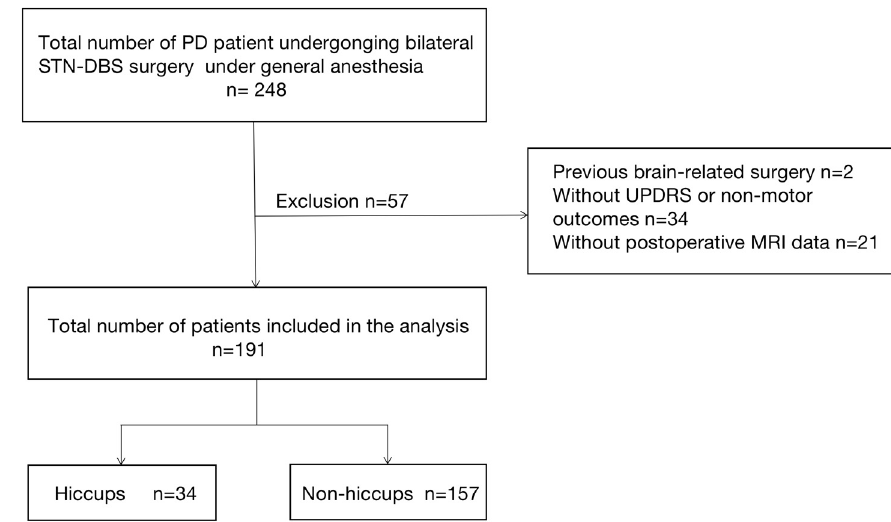
Figure 1. Data collection and analysis flowchart.